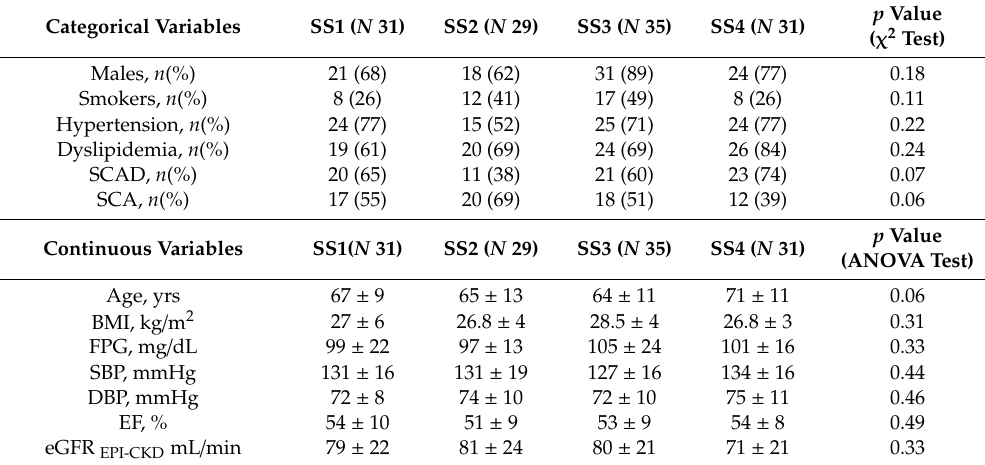
Table 1. Baseline